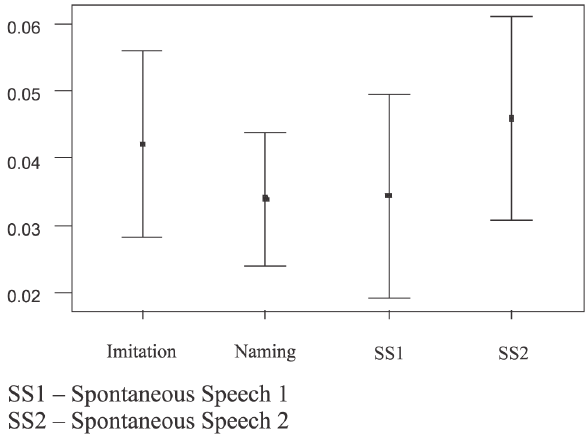
Figure 5 - Averages of distortion proportions in the Group with Phonological